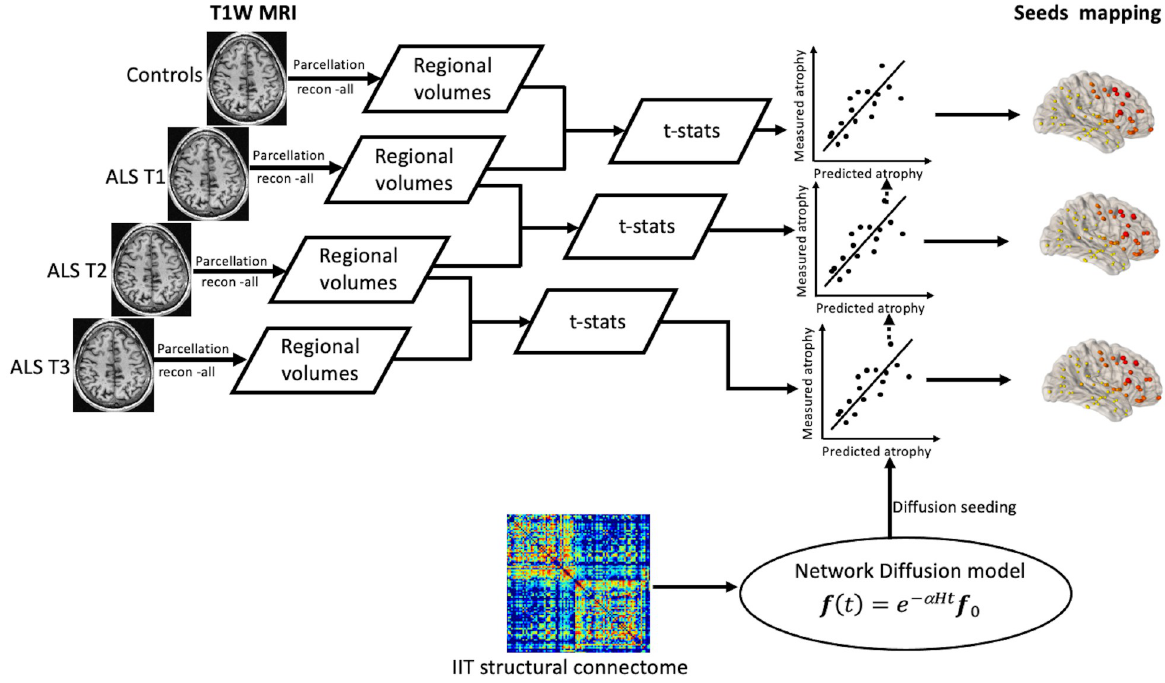
Fig 1. A flow diagram for the data analysis process used in this study. FreeSurfer was used to parcellate and segment the T1W data into 82 distinct cortical and sub-cortical brain regions based on the Deskian-Killiany atlas. For each region, t-statistics of the volumetric difference between the ALS patient group and the control group were estimated. The t-statistics were measured between control subjects and ALS patients at baseline, ALS patients at baseline and at six-month follow-up, and ALS patients at six-month follow-up and at twelve-month follow-up. The structural connectome data were obtained from the existing IIT Human Brain Atlas (V.5.0). Based on the repeated seeding approach, NDM was implemented to identify the epicentre of the disease. For each brain region, the network diffusion model was used to estimate the diffusion at all other regions. The association between NDM estimates (predicted atrophy) and t-statistics (measured atrophy) were investigated using Parsons’s correlation. The maximum correlation value for each seed region was used to estimate the likelihood of that region being involved in the spread of the pathology in ALS. ALS T1: ALS baseline scan. ALS T2: ALS six-month follow-up scan. ALS T3: ALS twelve-month follow-up scan.